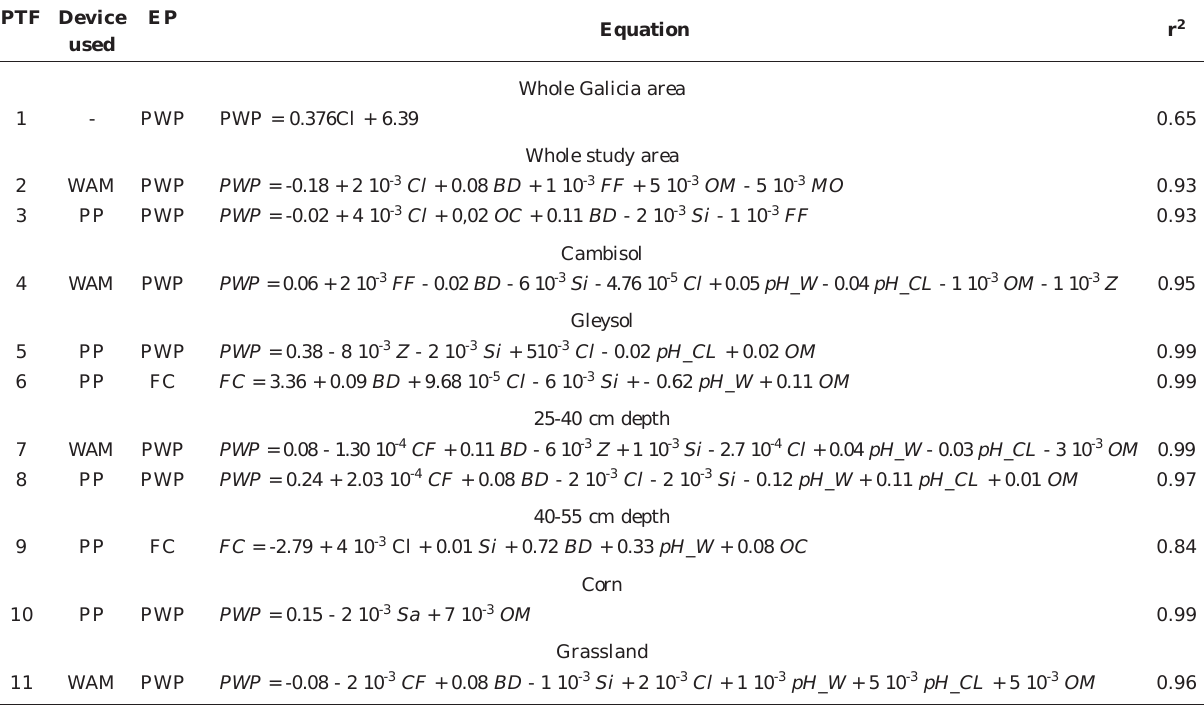
Table 3. Features of the specific pedotransfer functions (PTFs) proposed in different areas, soil type, sampling depth, crop type, devices used (water activity meters - WAM or pressure plates - PP), and estimated properties (EP) (permanent wilting point - PWP or field capacity -